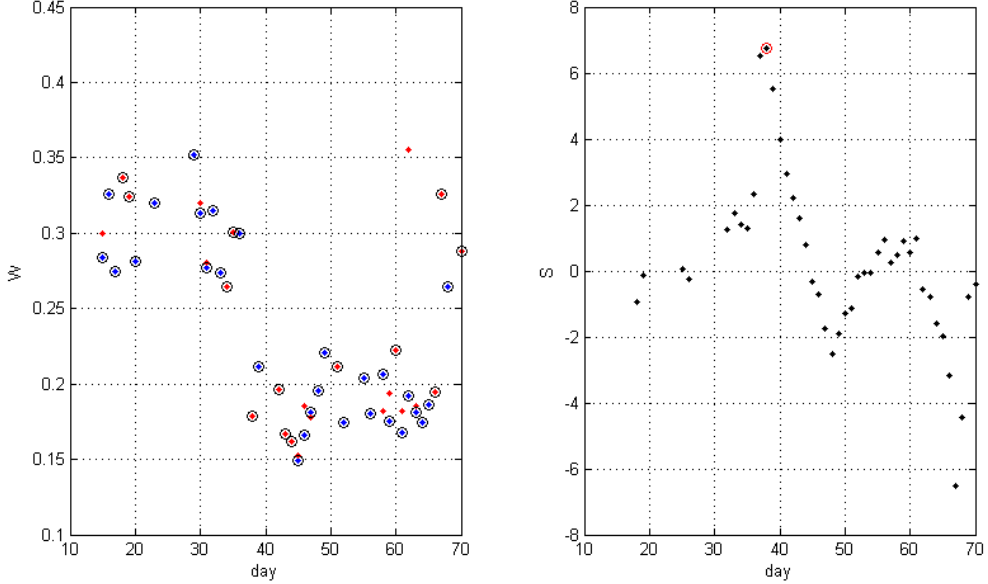
Figure 3 - Temporal series of W (left panel) and discrimination index S (right panel) for a selected pixel. Red and blue circles (left panel) distinguish Terra and Aqua data, respectively. The highest value of S is represented by a red circle (right panel) and corresponds to the day with a sudden and large decrease in W (left panel).